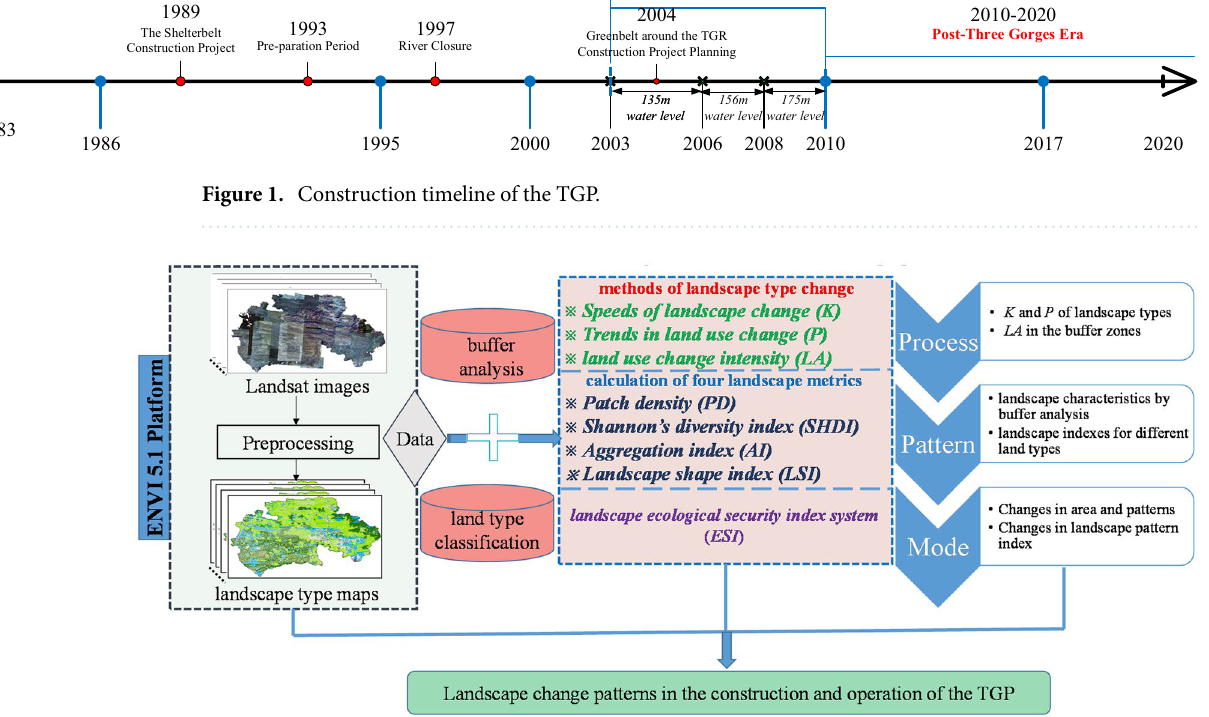
Figure 2. Flowchart for the evolution of landscape change patterns in this